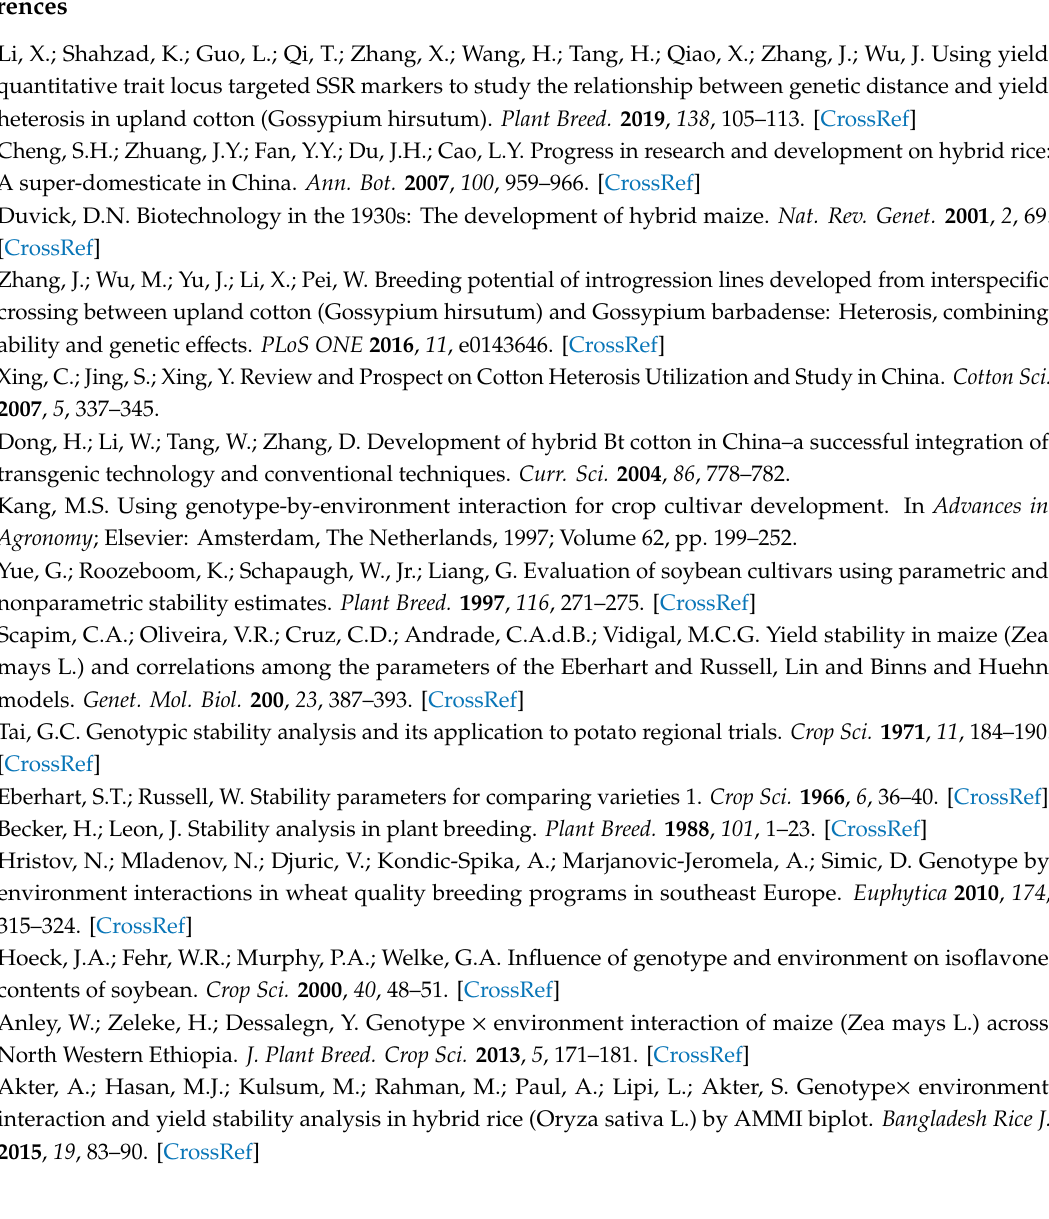
Table S2: Comparisons of mean for genotypes across six environments for yield traits. Table S3: Comparisons of mean for genotypes across six environments for fiber quality traits. Figures S1, S6, S9, S11, and S14 shows mean performance and stability of 41 genotypes at six environments for number of bolls per plant, lent percentage, fiber elongation, fiber uniformity and fiber micronaire, respectively. Figures S2–S5, S7, S8, S10, S12, S13, and S15 represents CV% of 41 genotypes at six environments for number of bolls per plant, boll weight, seed cotton yield, lint yield, lent percentage, fiber upper half mean length, fiber elongation, fiber uniformity, fiber strength, and fiber micronaire,